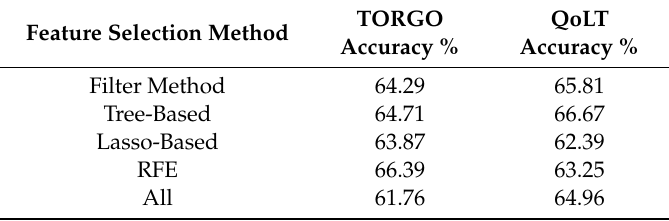
Table 6. Accuracy of di ff erent feature selection algorithms using prosody-based